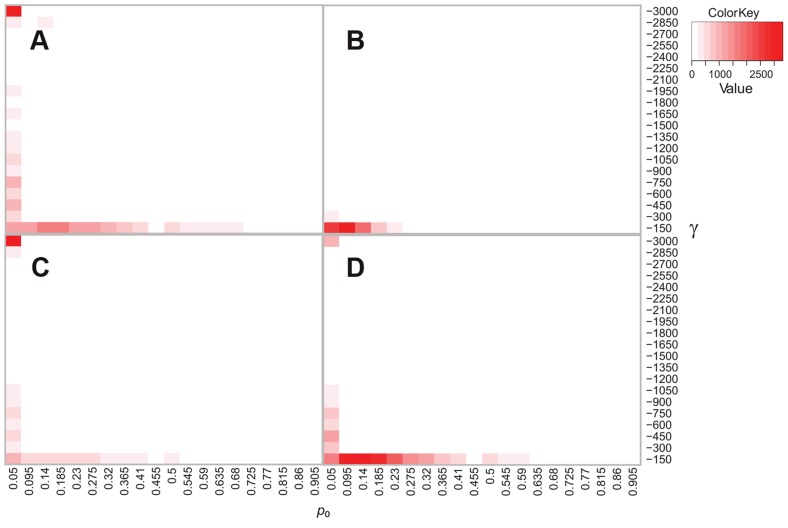
Simulation and inference under purifying selection and complete linkage.Results of four sets of simulation experiments (10,000 simulations/set). In all cases, a single completely linked locus of length equal to 2,753,618 bp was simulated under purifying selection, and inference of selection was done with a two parameter model (category of neutral sites plus single selection coefficient at remaining sites). The composite parameter γ ( = 2Nes) and proportion of neutral sites (p0) were estimated from the simulated data. These are shown on the Y and X axes of each panel, respectively. The number of counts of simulations with estimates within each grid value is indicated in the color key. A) Simulated γ = 1, p0 = 0; B) Simulated γ = 10, p0 = 0; C) Simulated γ = 1, p0 = 0.9; D) Simulated γ = 10, p0 = 0.9. Simulations of relatively weak purifying selection (panels A & C) paradoxically result in inference of extremely strong purifying selection (γ∼−3,000) in a large proportion of cases. This pattern disappears when stronger selection is simulated (panel B). Even when 90% of sites are evolving neutrally, purifying selection is inferred at a large proportion of sites (panels C & D), likely due to linkage of sites.